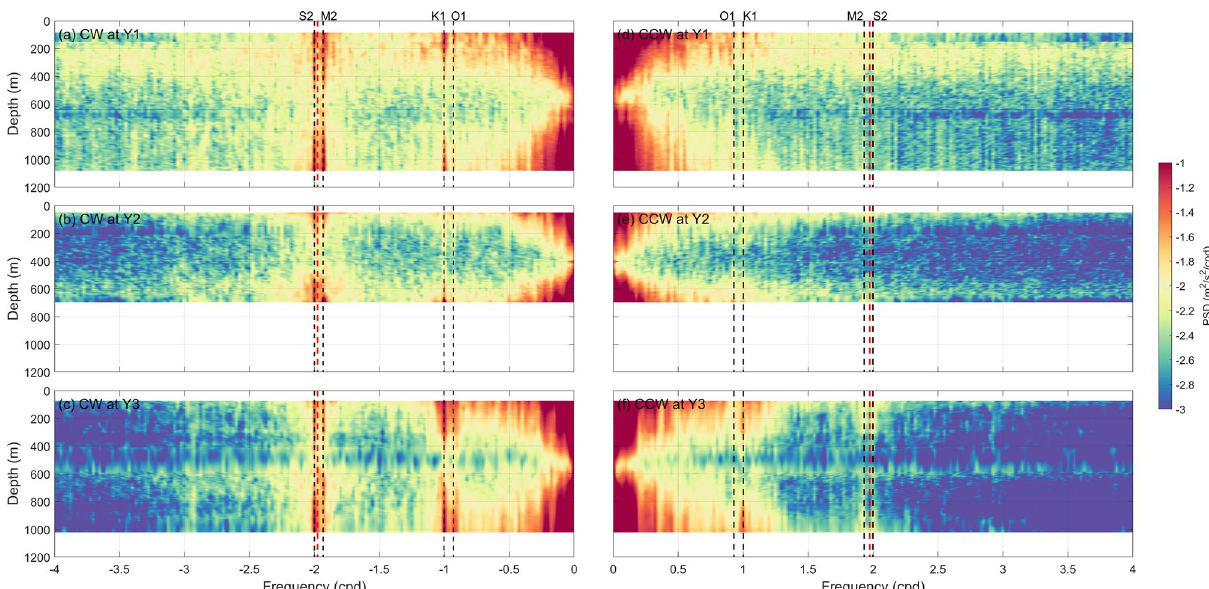
Figure 2. Rotary frequency spectra of horizontal baroclinic velocities at the three moorings (shading, unit: m 2 / s 2 /cpd). CW and CCW components are shown in ( a – c ) and ( d – f ), respectively. Tidal frequencies are indicated by black dashed lines, while local inertial frequency by red dashed